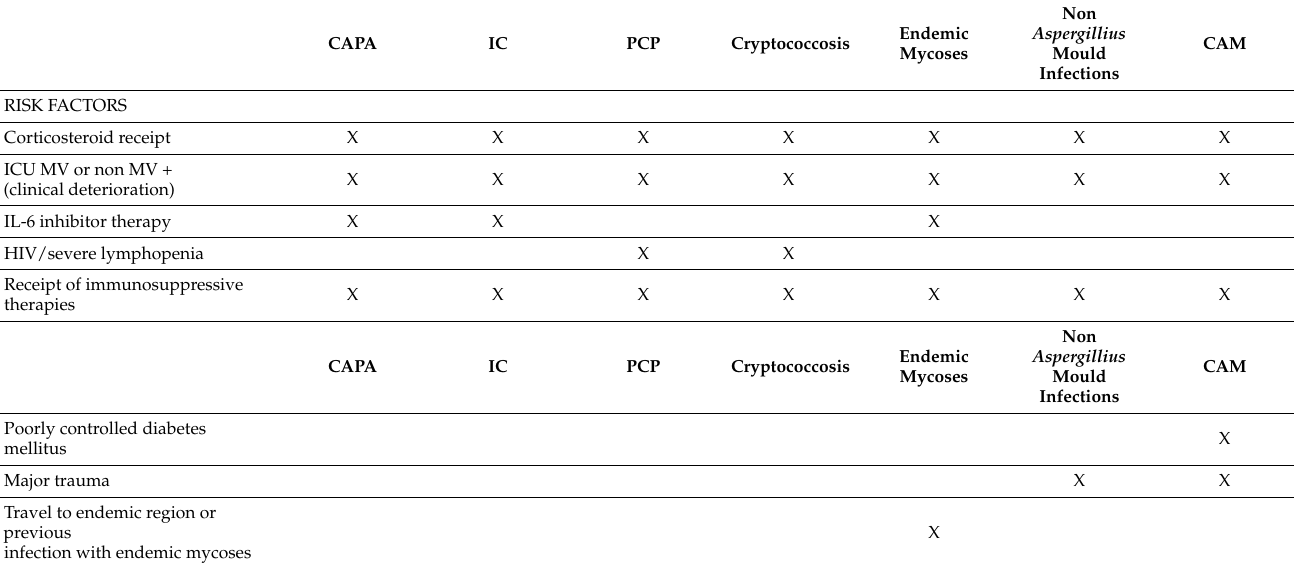
Table 2. Summary of risk factors in COVID-19 patients for invasive fungal disease and diagnostic